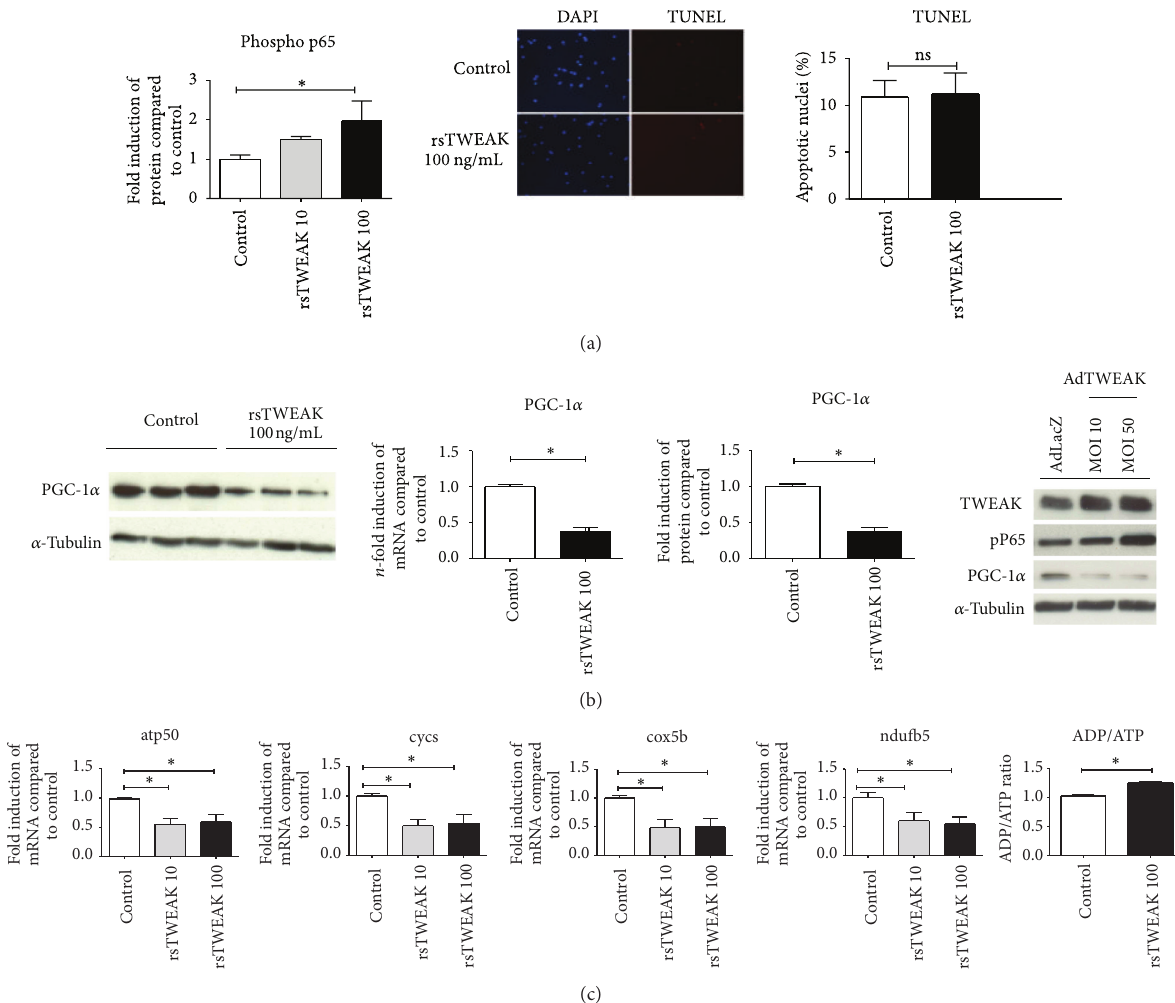
Figure1:TWEAKdirectlypromotesmetabolicmaladaptationbyPGC-1 𝛼 andOXPHOSgeneinhibitionincardiomyocytes.(a)TWEAKdose dependently phosphorylated p65 without affecting cardiomyocyte apoptosis. TUNEL assay (b). Recombinant sTWEAK directly inhibited PGC-1 𝛼 on mRNA and protein level in cardiomyocytes. Similar results could be observed by using an adenoviral vector containing TWEAK asan insert.(c)Likewise, OXPHOS genes likeatp5O, ndufb5, cycs, and cox5b werealsodosedependently inhibitedby recombinant sTWEAK, which resulted in an overall increased ADP/ATP ratio ( 𝑛 = 4 for each experimental